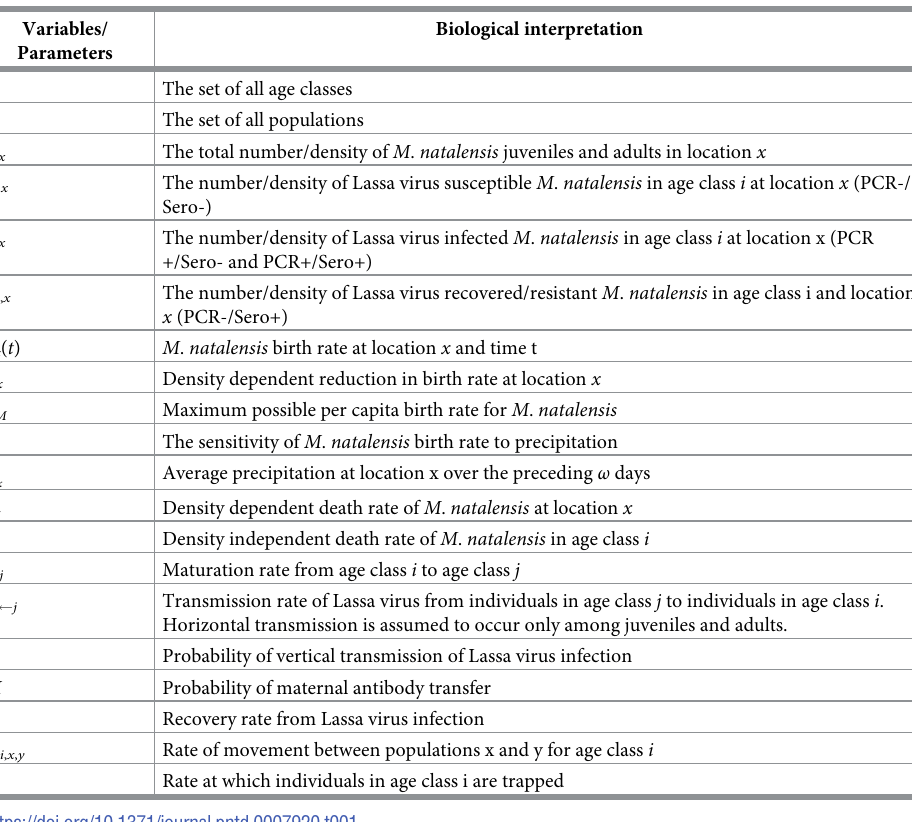
Table 1. Model variables and